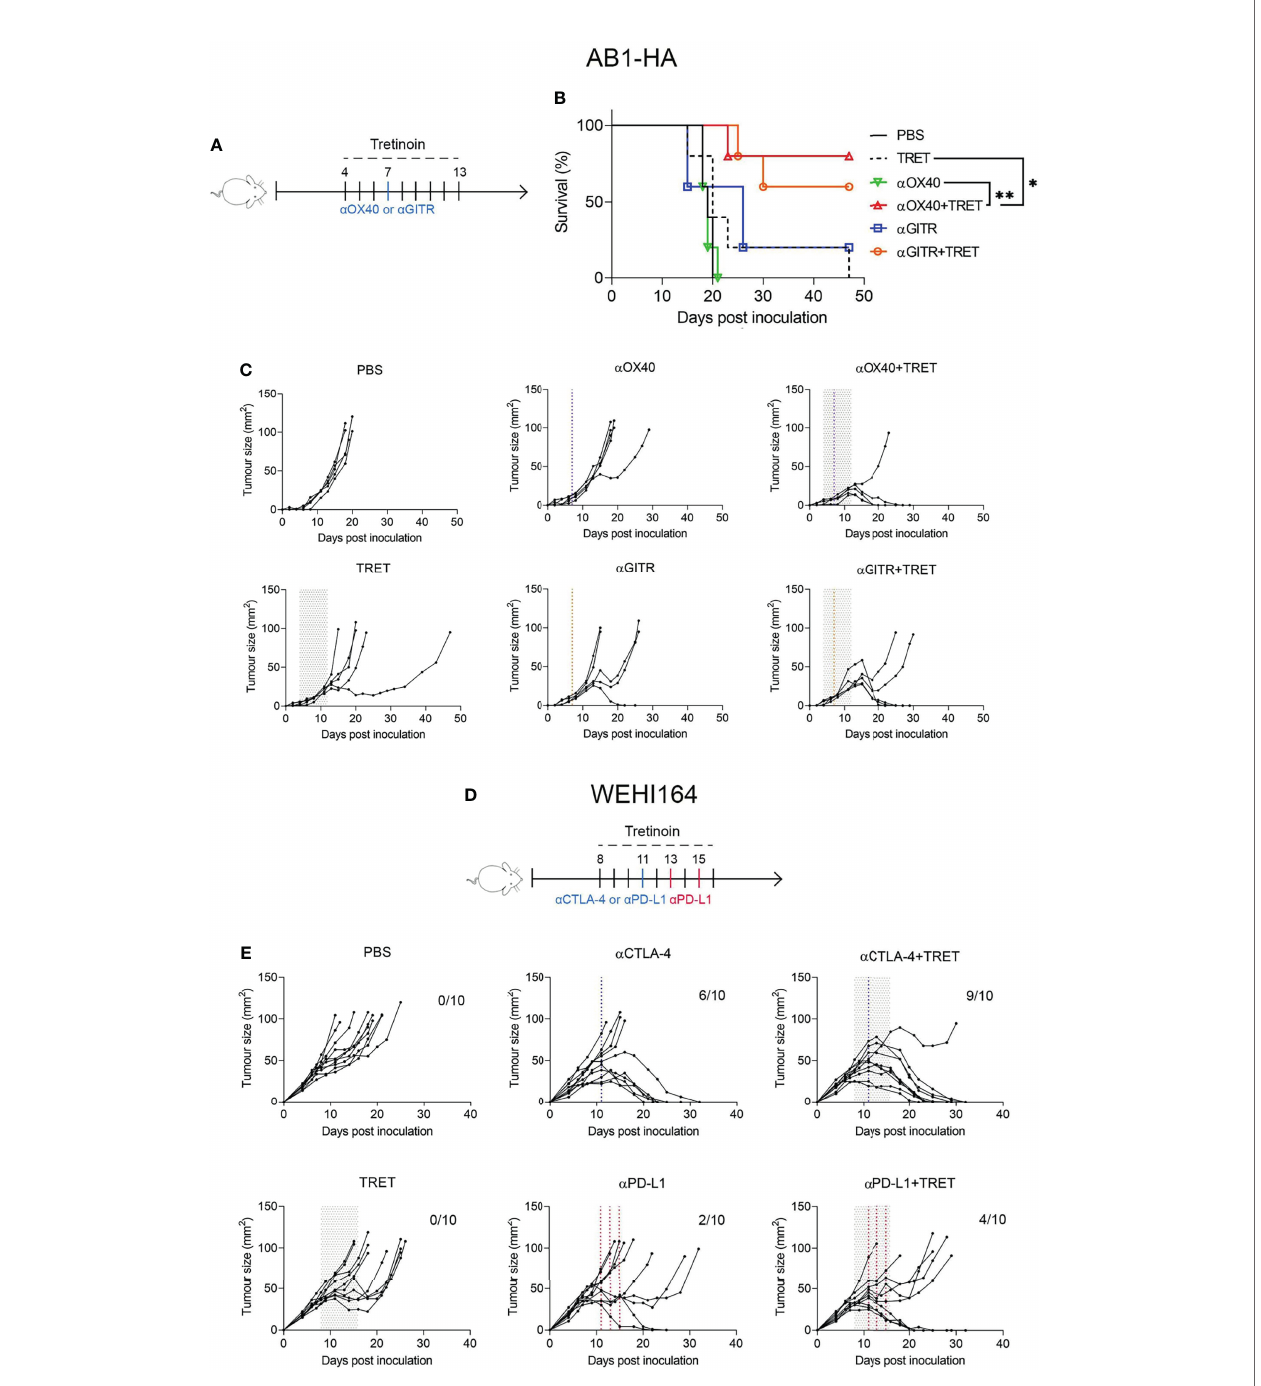
FIGURE 5 | Tretinoin improves the anti-tumour ef fi cacy of single agent ICT in AB1-HA mesothelioma and WEHI164 fi brosarcoma. (A) Experimental design. AB1-HA bearing mice were treated with anti-GITR ( a GITR) or anti-CD40 ( a OX-40) antibodies (day 7), with or without tretinoin dosed in the staggered schedule beginning on day 4 when tumours were ~4 mm 2 (n=5). (B) Individual tumour growth curves. (C) Survival of AB1-HA bearing mice. (D) Experimental design. Mice bearing WEHI- 164 were treated with CTLA4 ( a CTLA-4) or anti-PD-L1 ( a PD-L1) on day 11, with or without staggered tretinoin commencing on day 8 when tumours were ~40 mm 2 (n=10). (E) Individual tumour growth curves of WEHI164 inoculated mice treated with ICT and TRET. The log-rank test was used for survival analysis and a mixed model ANOVA for tumour growth analysis. *p < 0.05 **p <